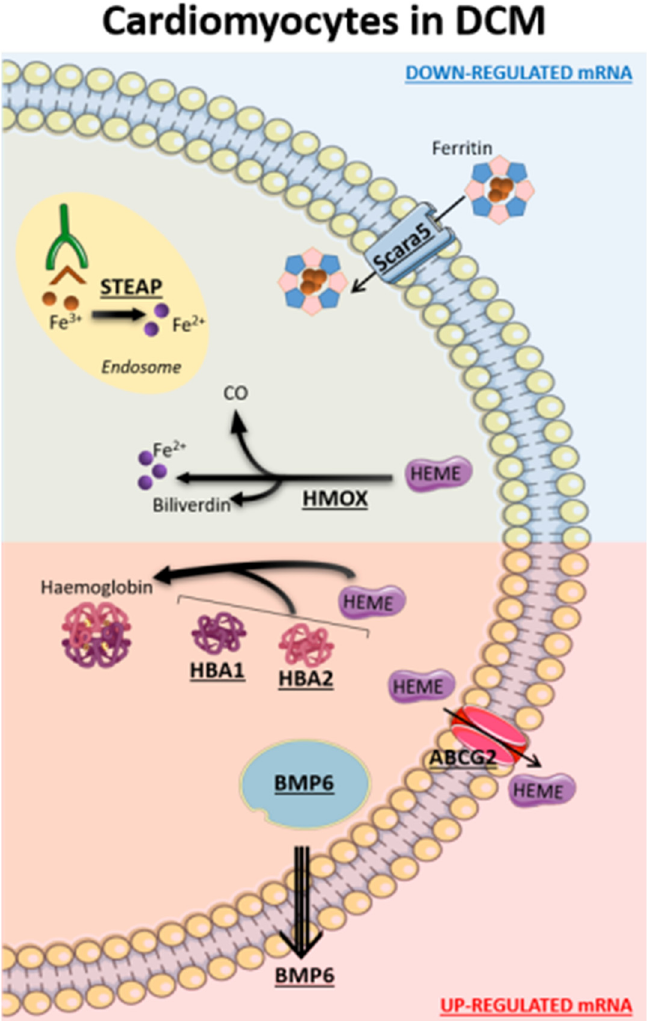
Figure 3. Iron-linked affected genes in dilated cardiomyopathy (DCM) cardiomyocytes. Down-regulated proteins are represented in the region with the blue background, while the up-regulated ones are in the region with the red background. ATP binding cassette subfamily G member 2 (ABCG2), delta-aminolevulinic synthase 2 (ALAS2), bone morphogenetic protein 6 (BMP6), hemoglobin sub- unit alpha 1/2 (HBA1/2), heme oxygenase 1/2 (HMOX1/2), scavenger receptor class A mem- ber 5 (SCARA5), solute carrier family 25 member 28 (SLC25A28), six-transmembrane epithelial antigen of the prostate 3/4